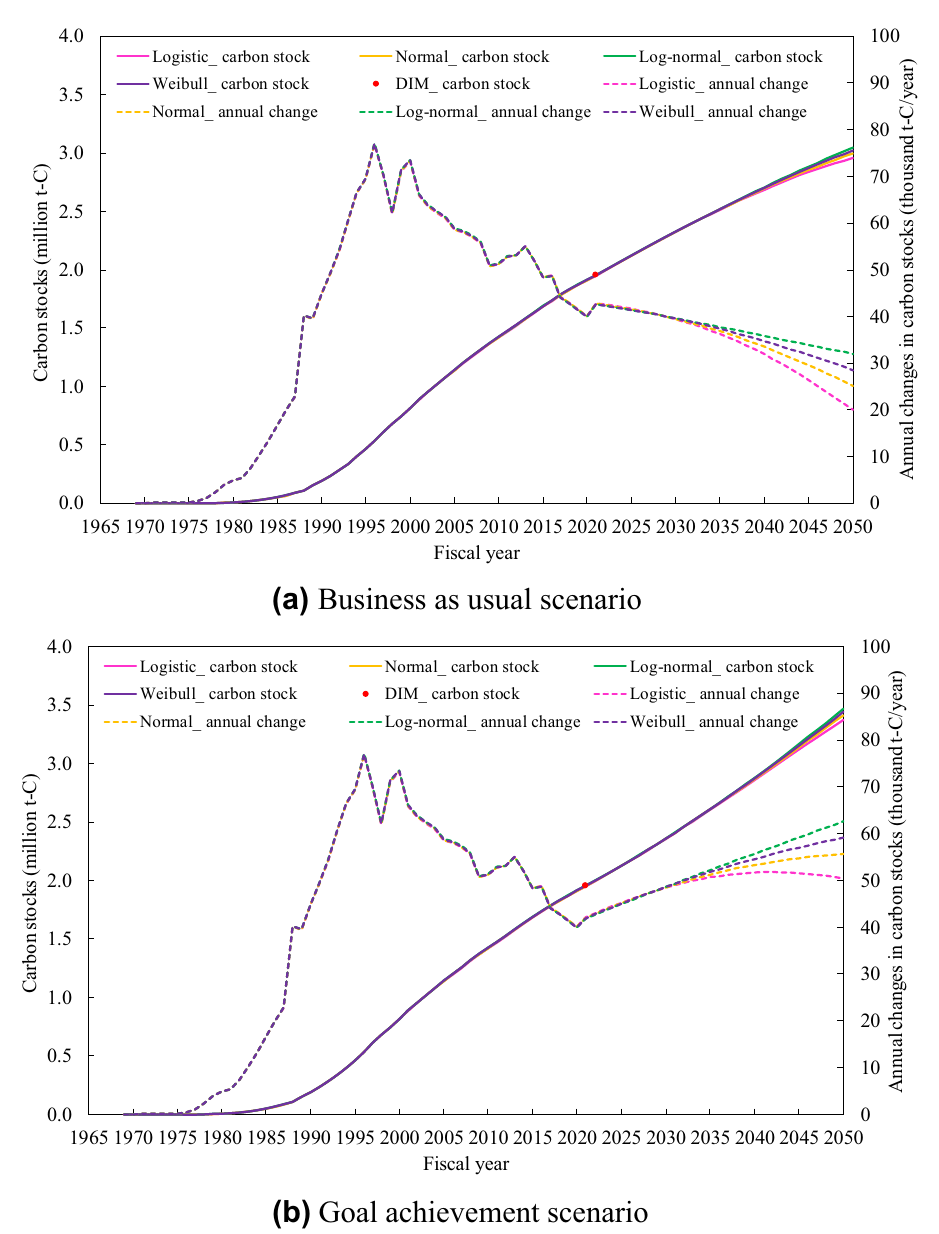
Figure 3. Future prediction of carbon stocks in wood products used in existing wooden houses until FY2050. ( a ) Business as usual scenario: The yearly average number of wooden houses built for the past five years during FY2016–FY2020 (8348 houses/yr) was assumed to continue to FY2050. ( b ) Goal achievement scenario: The target company’s goal of the number of domestic wooden houses built in FY2030 (10,000 houses/yr) was assumed to be attained and it continued with the same increasing trend till